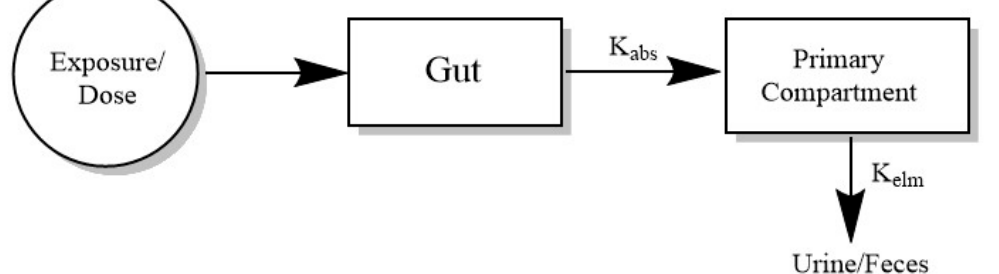
Figure 2. Overall structure for building a two-compartment model considering absorption and elimination rate constant.